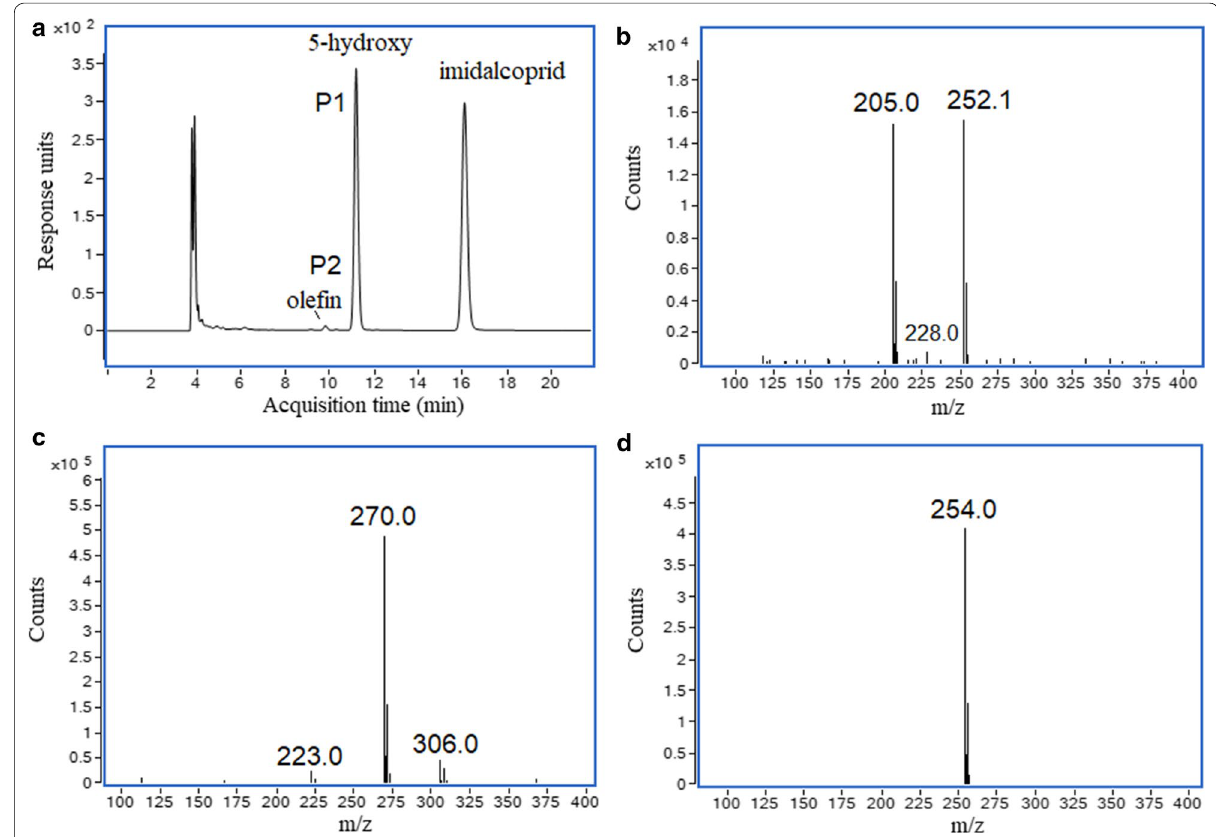
Fig. 4 Liquid chromatography-mass spectrometry analysis of metabolites formed in the transformation of imidacloprid by resting cells of H. latericoloratus CGMCC 16346. a Chromatogram of resting cell degradation of imidacloprid. b – d Mass of the metabolites with retention times of 9.8, 11.2 and 16.0 min, respectively